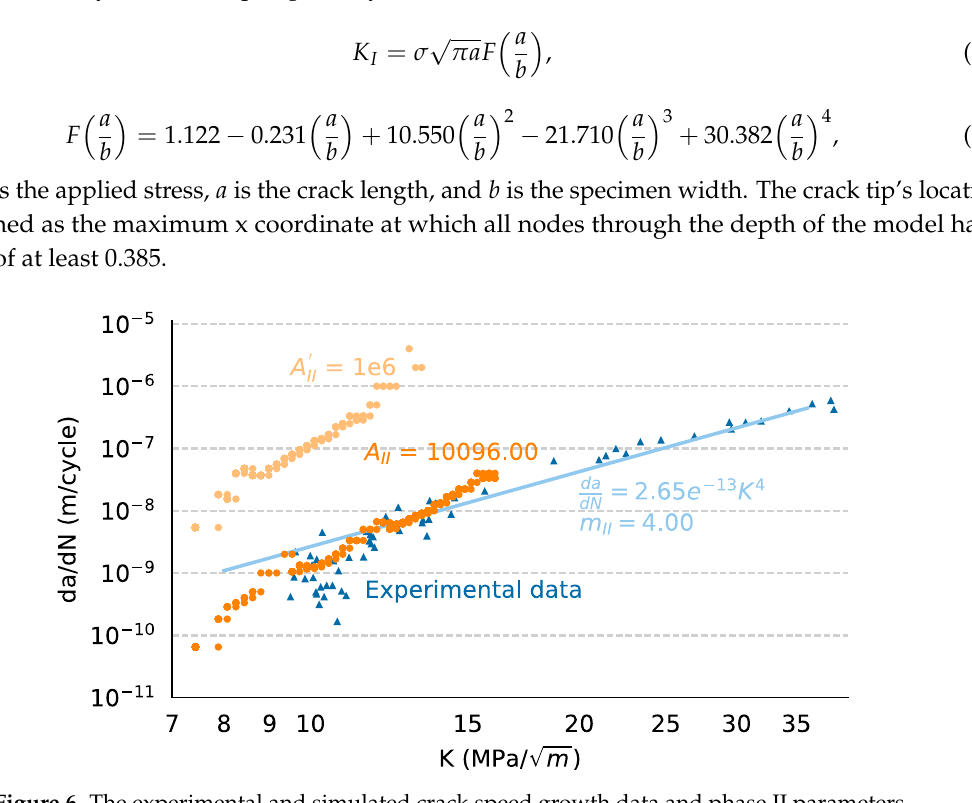
Figure 6. The experimental and simulated crack speed growth data and phase II parameters.